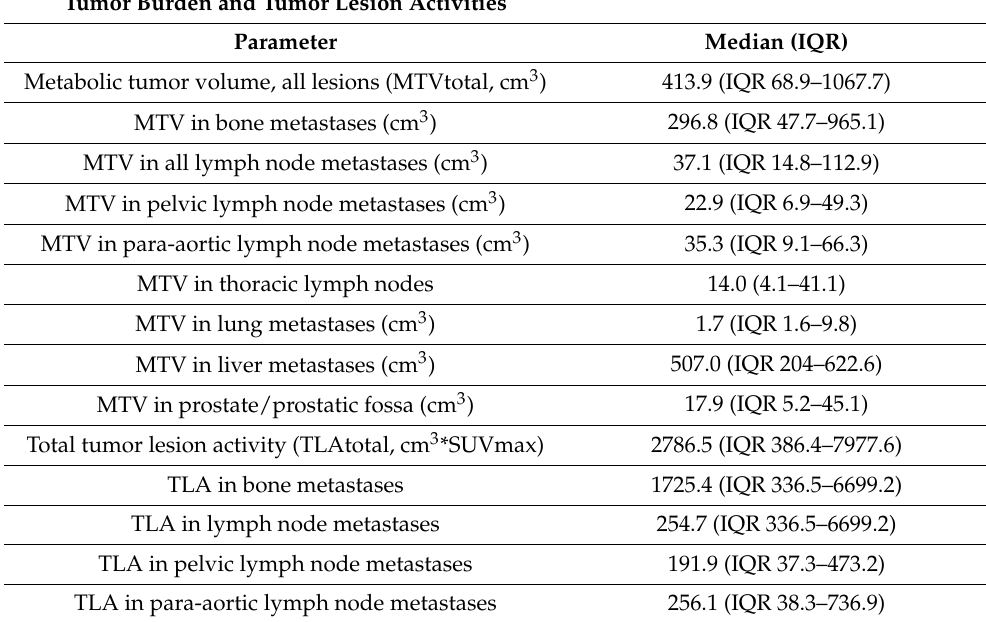
Table 2. Metastatic tumor volumes (MTV), tumor lesion activity (TLA) and regional SUVmax values in all lesions, in bone, in lymph node (all), in pelvic lymph nodes, in abdominal lymph nodes, in thoracic lymph nodes, in prostate/prostatic fossa and in liver and lung metastases. Tumor Burden and Tumor Lesion Activities Parameter Median (IQR) Metabolic tumor volume, all lesions (MTVtotal, cm 3